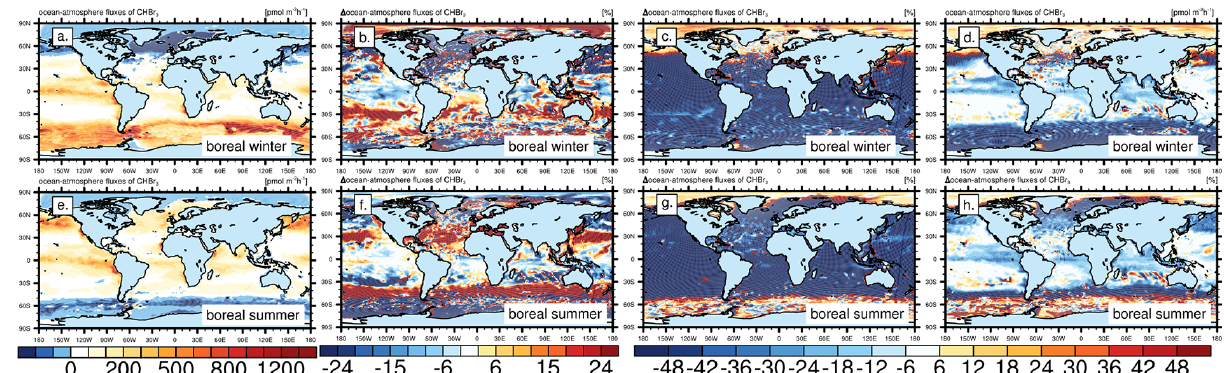
Figure 7. Mean bromoform sea–air flux (pmolm − 2 h − 1 ) in experiment Ref in boreal winter (a) and boreal summer (e) and the percentage ) of Seas-at (b, f) , Half (c, g) , and Dia (d, h) in the same season. difference (e.g. 100 · Seas − at − Ref Ref